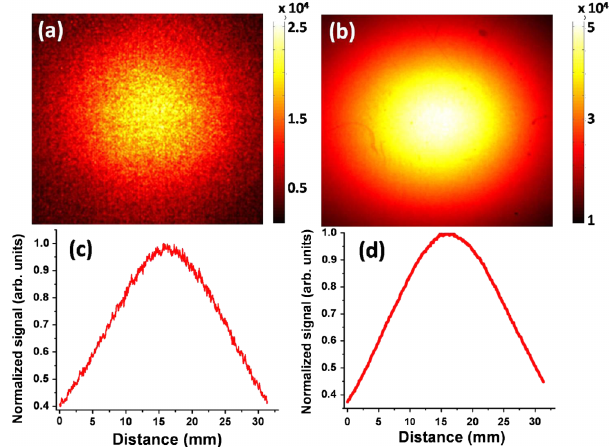
FIG. 7. The spatial distribution of fast electrons ( > 70 keV ) measured at the rear of the (a) hollow PAA and (b) metal-filled PAA targets. The line cut of the image (a) and (b) are shown in (c) and (d),